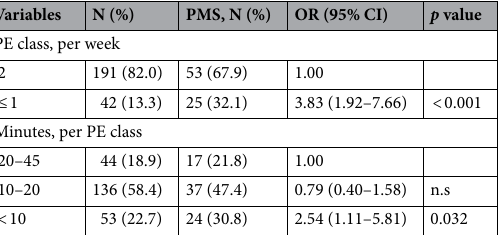
Table 2. Binary logistic regression analyses of variables associated with PMS. OR odds ratio, CI confidence intervals, PE physical education, PMS premenstrual syndrome.